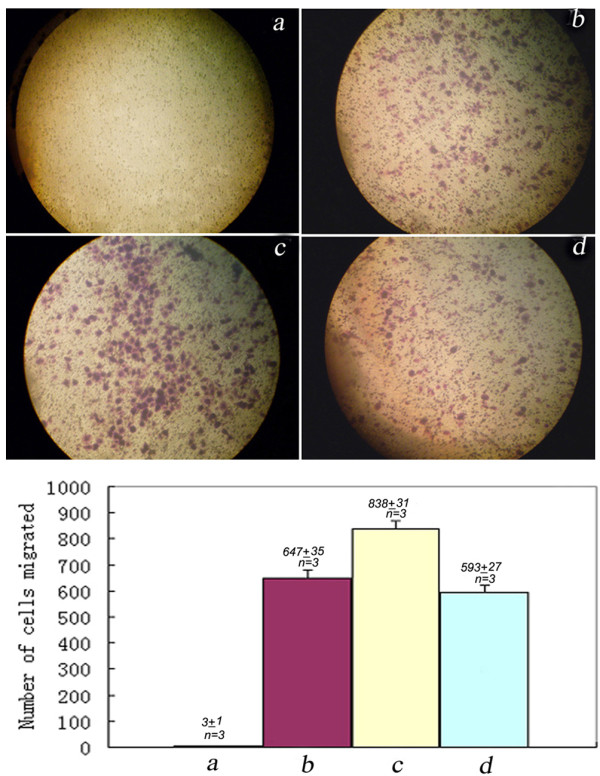
Effects of PRDX3 siRNA transient transfection on the migration capability of metastatic 5-8F cells. Effect of PRDX3 siRNA transient transfection on migration capability of metastatic 5-8F cells. The top shows four representative micrographs of metastatic 5-8F cells migrated through Transwell insert membranes among four experimental groups (400 ×). The bottom shows the quantitative comparison of the number of cells that migrated through Transwell insert membranes. Group A (a): nonmetastatic 6-10B cells. Group B (b): metastatic 5-8F cells. Group C (c): metastatic 5-8F cells with PRDX3 siRNA transient transfection. Group D (d): metastatic 5-8F cells with a scramble sequence siRNA transient transfection. Transwell migration assays were carried out triply (n = 3).